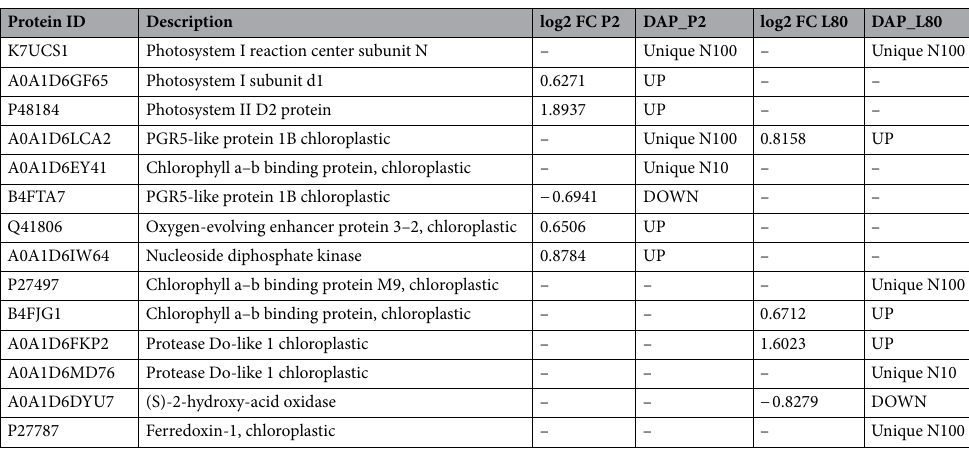
Table 2. Differentially accumulated proteins related to photosynthesis regulated in P2 and L80 inbred lines under high and low N